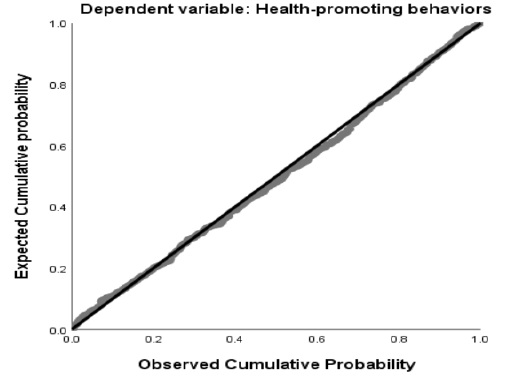
Figure A2. Normal P–P plot of regression standardized residual.